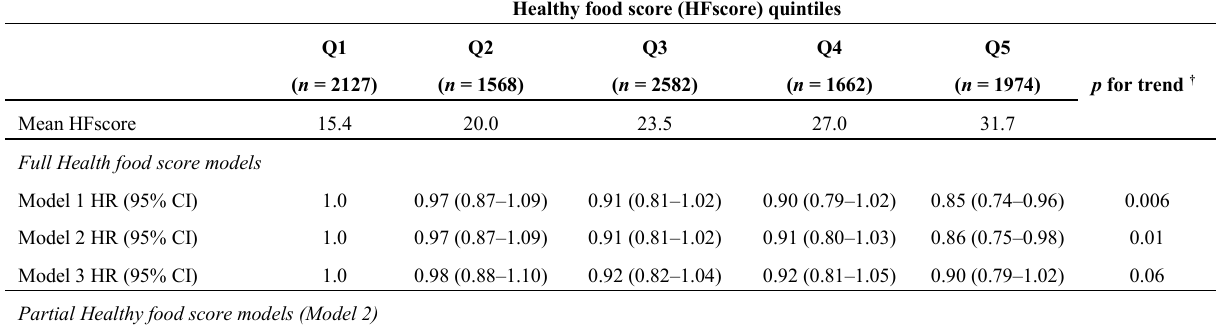
Table 4. Hazard ratios (HR) and 95% confidence intervals (95% CI) for incident hypertension* across Healthy Food Score quintiles, ARIC ( n = 9913),